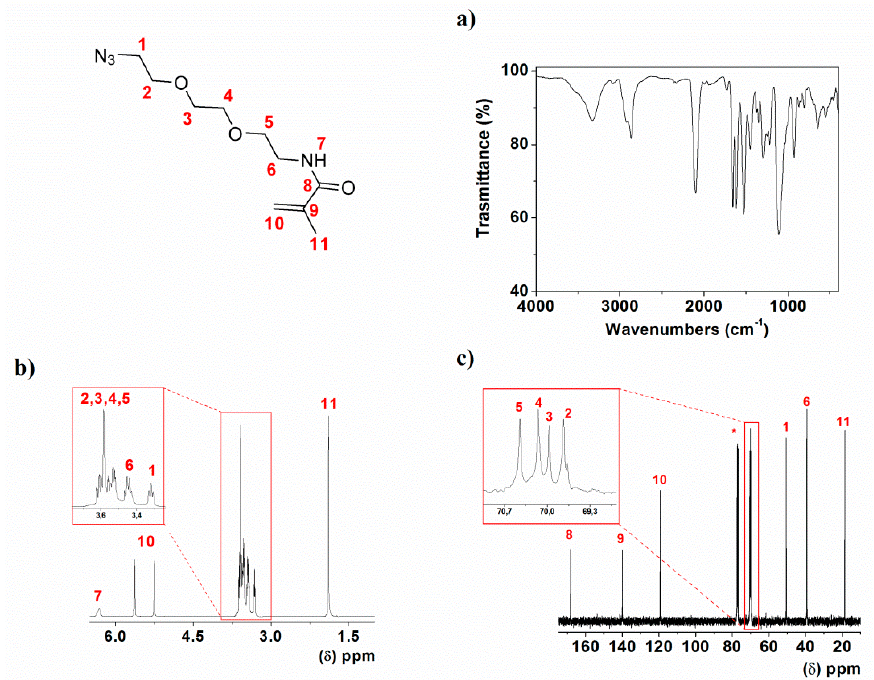
Figure 2. Characterization of AzMa2 by ( a ) FTIR, ( b ) 1 H ‐ NMR and ( c ) 13 C ‐ NMR (* = solvent signal, CDCl 3